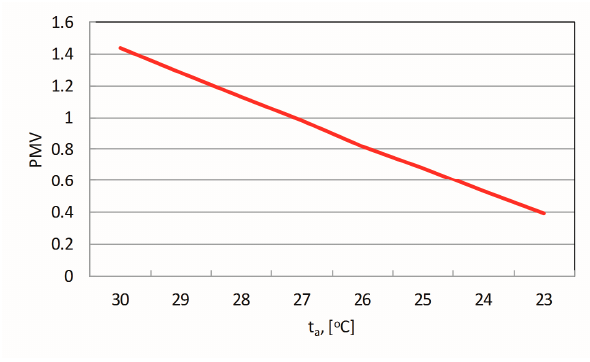
Figure 10. PMV depending on the air temperature(MRT = 30 °C. RH = 50%. v a = 0.1 m/s).